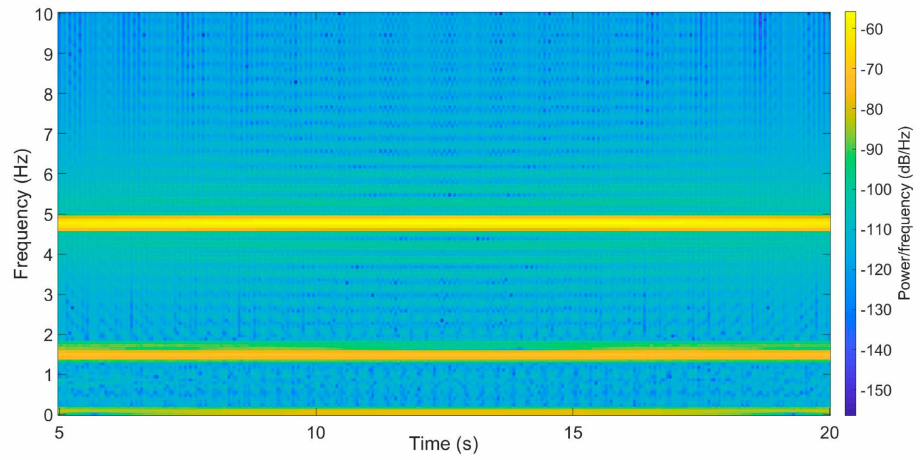
Figure 7. Short-time Fourier transformation of the healthy bridge accelerations with window size 200.